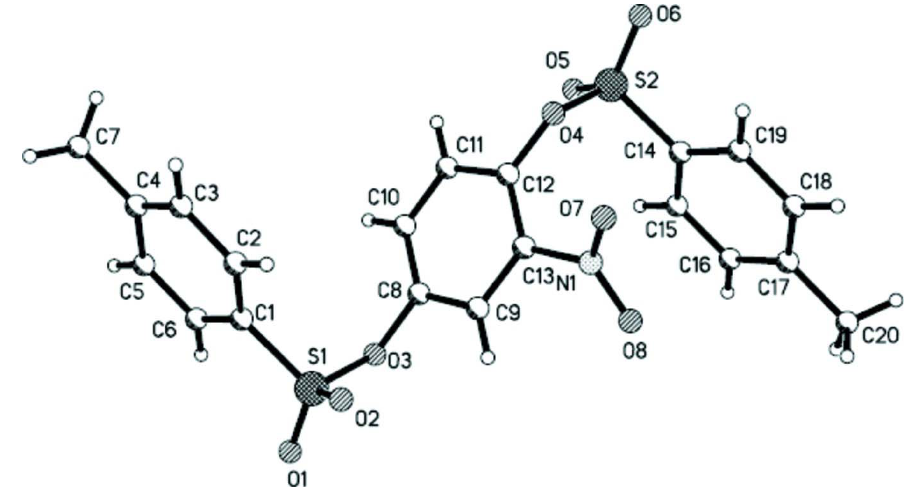
Figure 1 The molecular structure of the title molecule, with the atom-numbering scheme. Displacement ellipsoids are drawn at the 30% probability level.